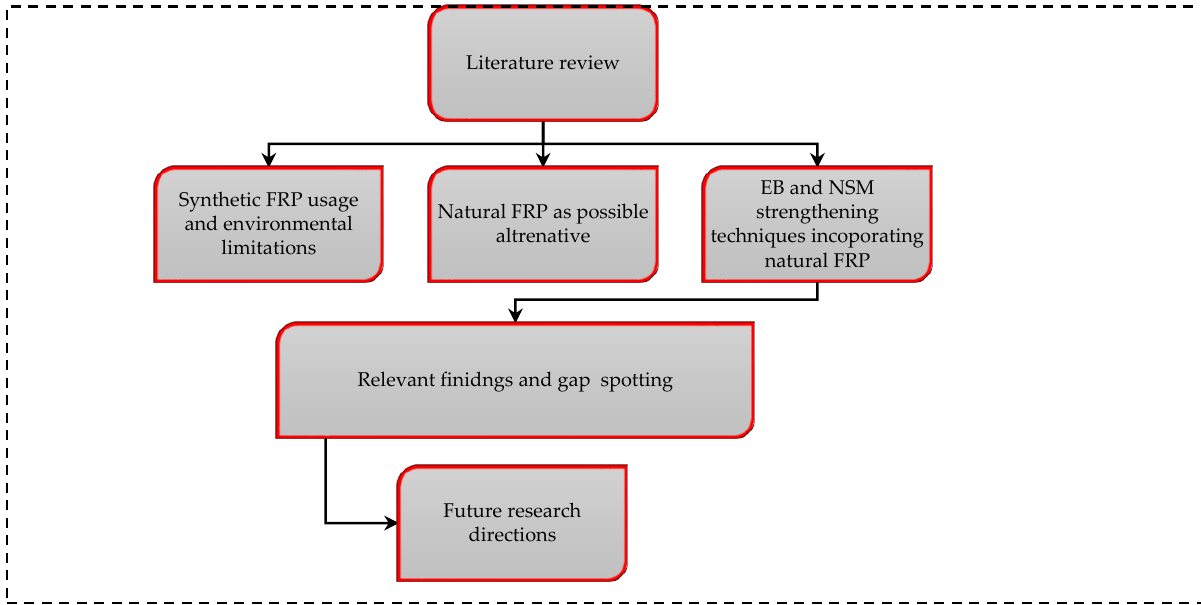
Figure 8. Flow chart of paper organization.